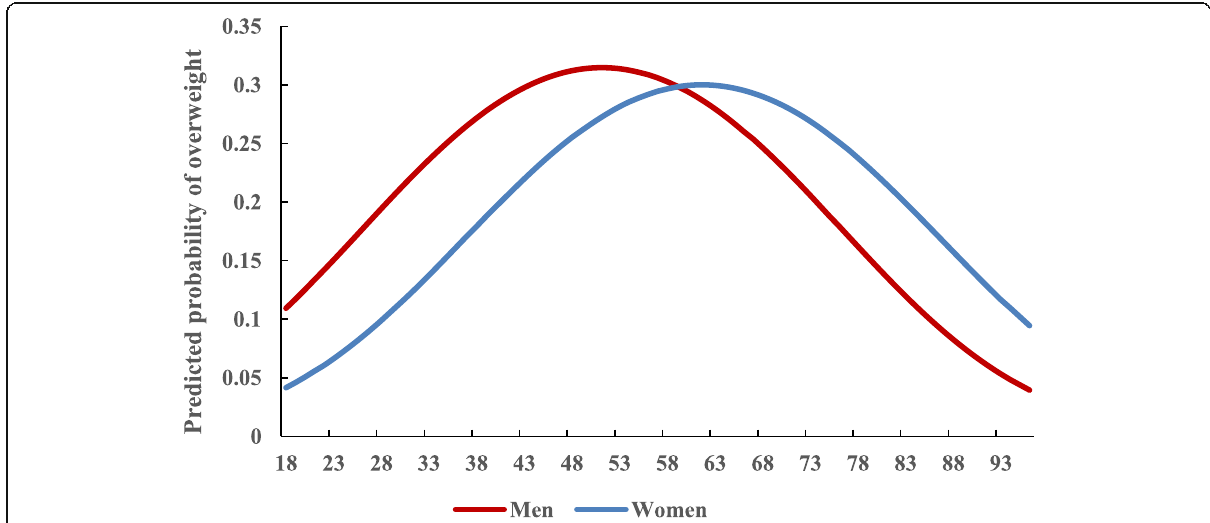
Fig. 1 Gender-specific age effects on overweight, adjusted for period and cohort effects and all covariates